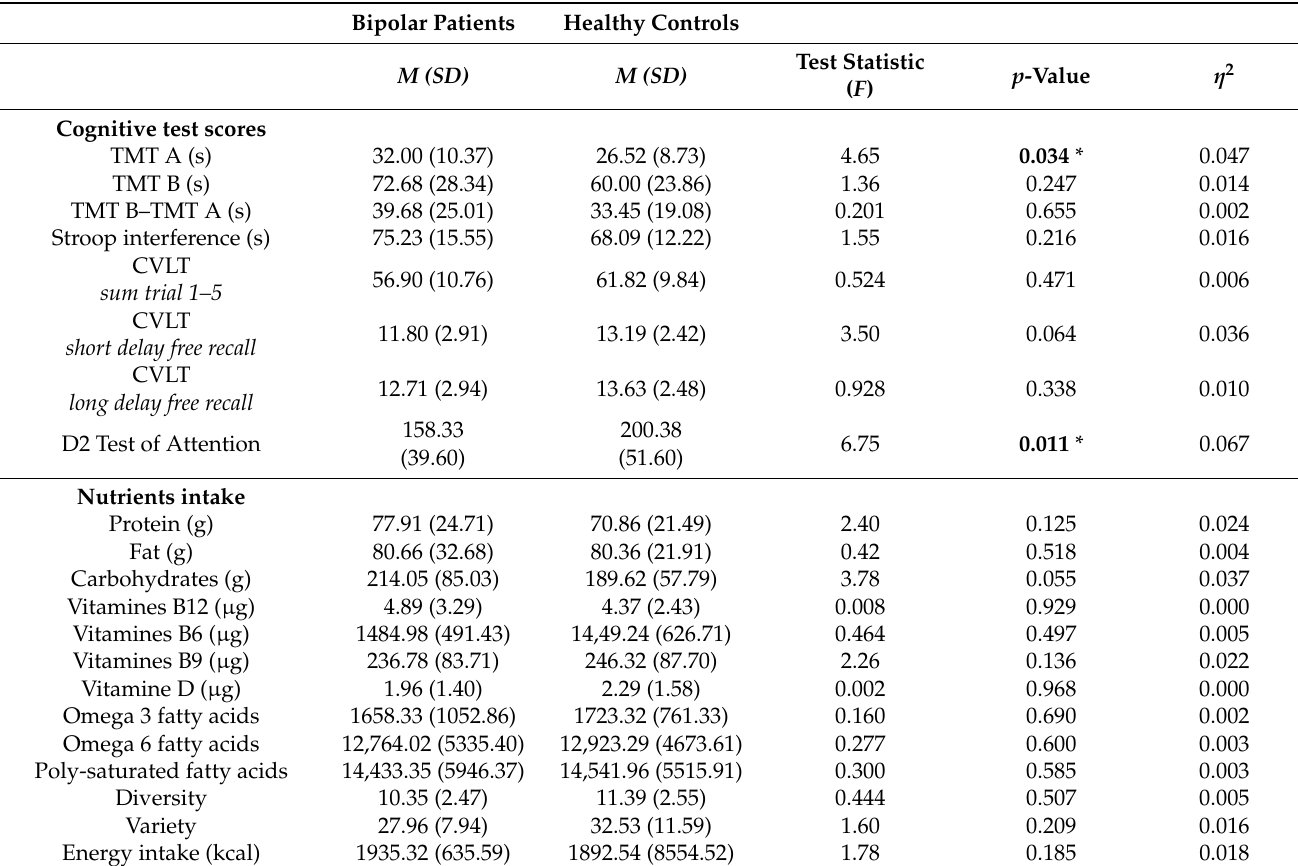
Table 2. Cognitive scores and nutrients intake in bipolar patients versus healthy controls. Bipolar